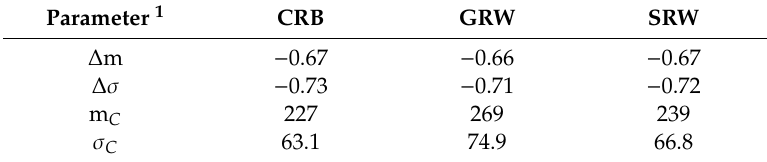
Table 3. Fitting parameters for the CRB and upstream GRW and SGW